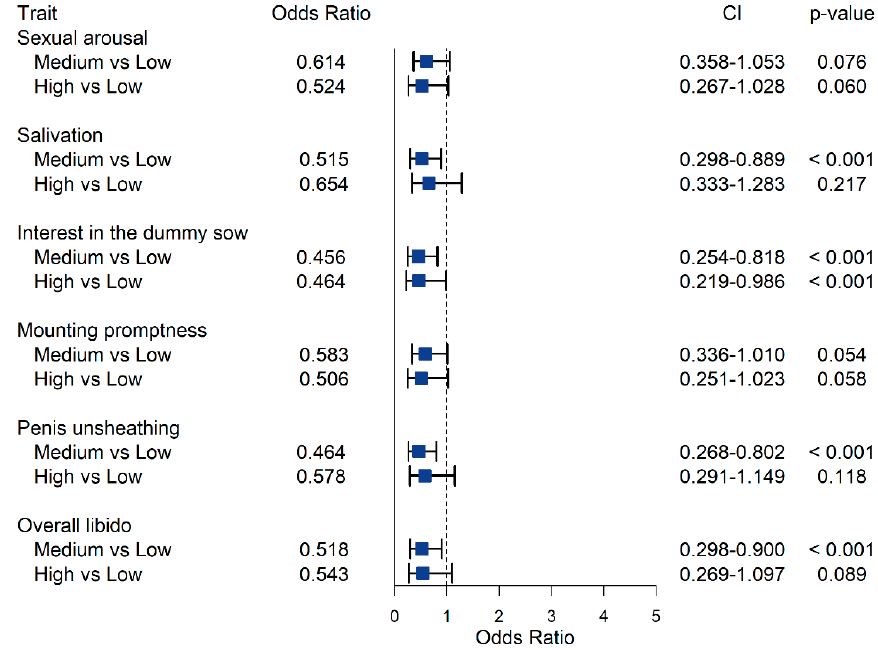
Figure 4. Odds ratio for the effect of average and high skatole concentration in subcutaneous adipose tissue, compared to low skatole concentration, on sexual behavior traits evaluated during the third training session. The dashed line corresponds to an odds ratio equal to 1.00.